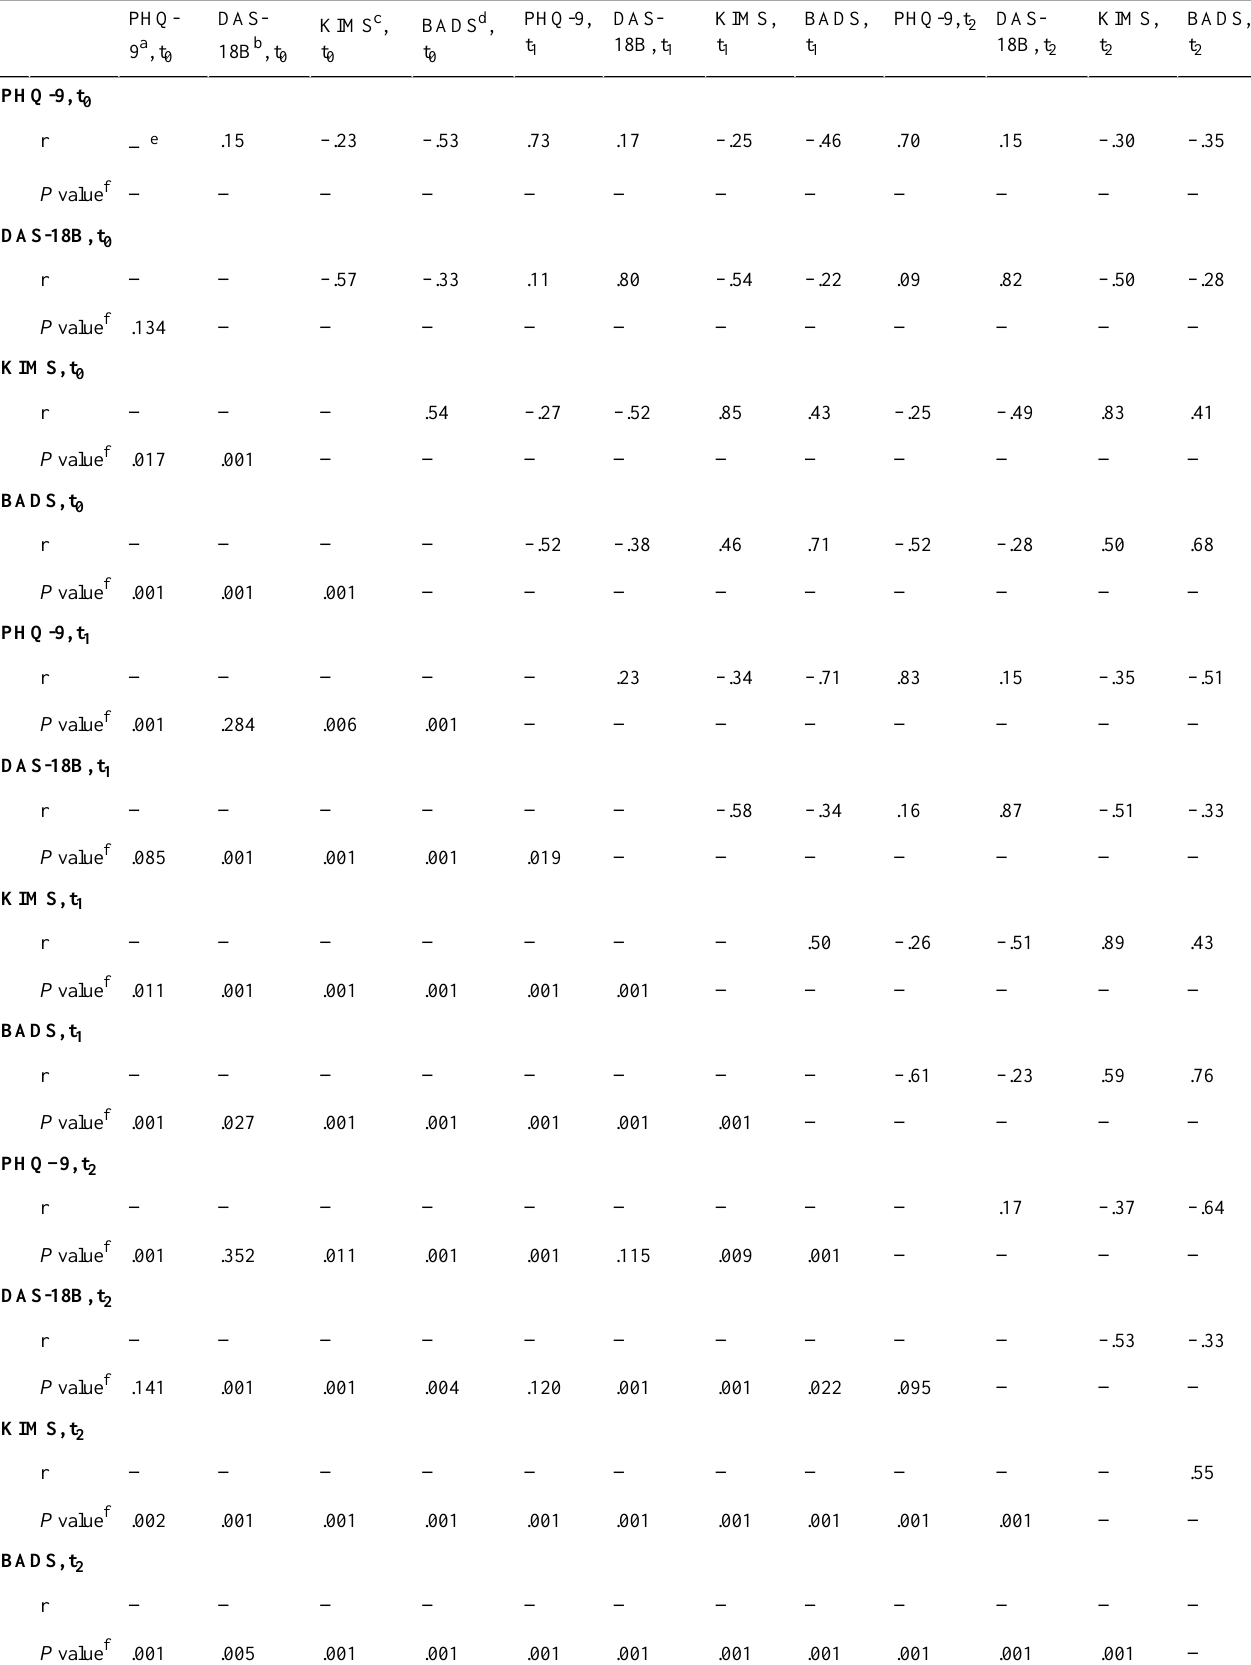
Table 5. Zero-order correlations for the primary and secondary outcomes at baseline (t 0 ), 2-week post-treatment (t 1 ), and 4-week follow-up (t 2